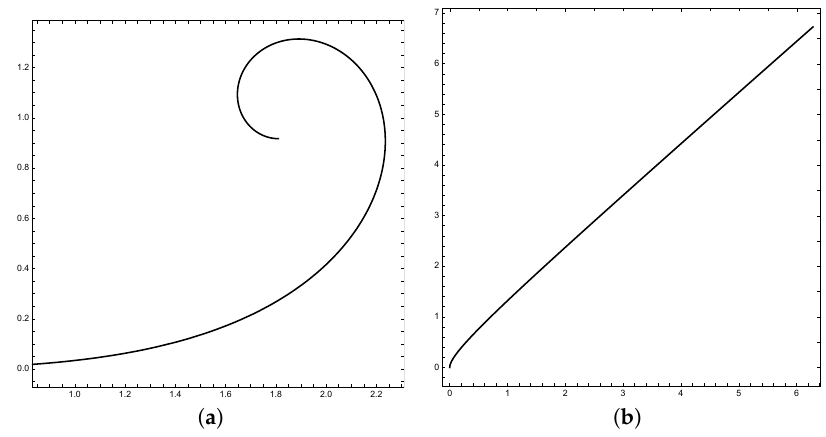
Figure 5. ( a ) Curve with ρ ( θ ) = U ( 1,1.5, θ ) , 0 ≤ θ ≤ 2 π , ( b ) curvature.